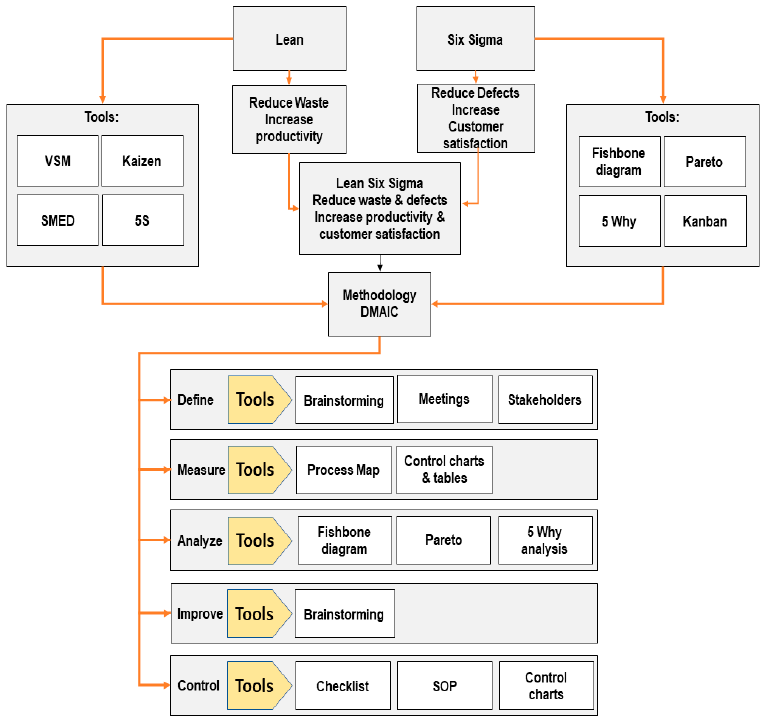
Figure 1. Flowchart for lean Six Sigma.